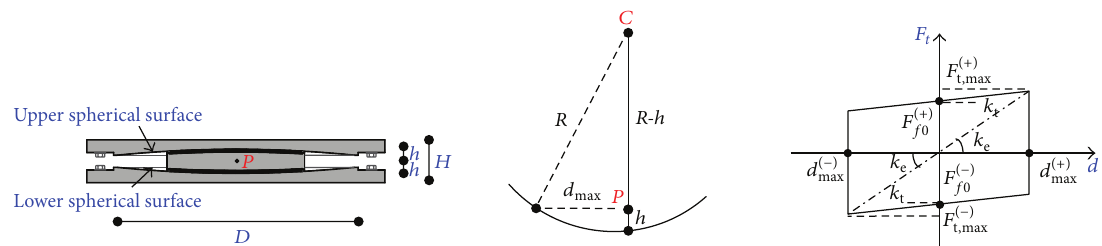
Figure 5: Cross section of a symmetrical DFP isolator, characterized by equal concave surfaces and friction coefficients, geometrical parameters of each spherical surface, and corresponding schematic 𝐹